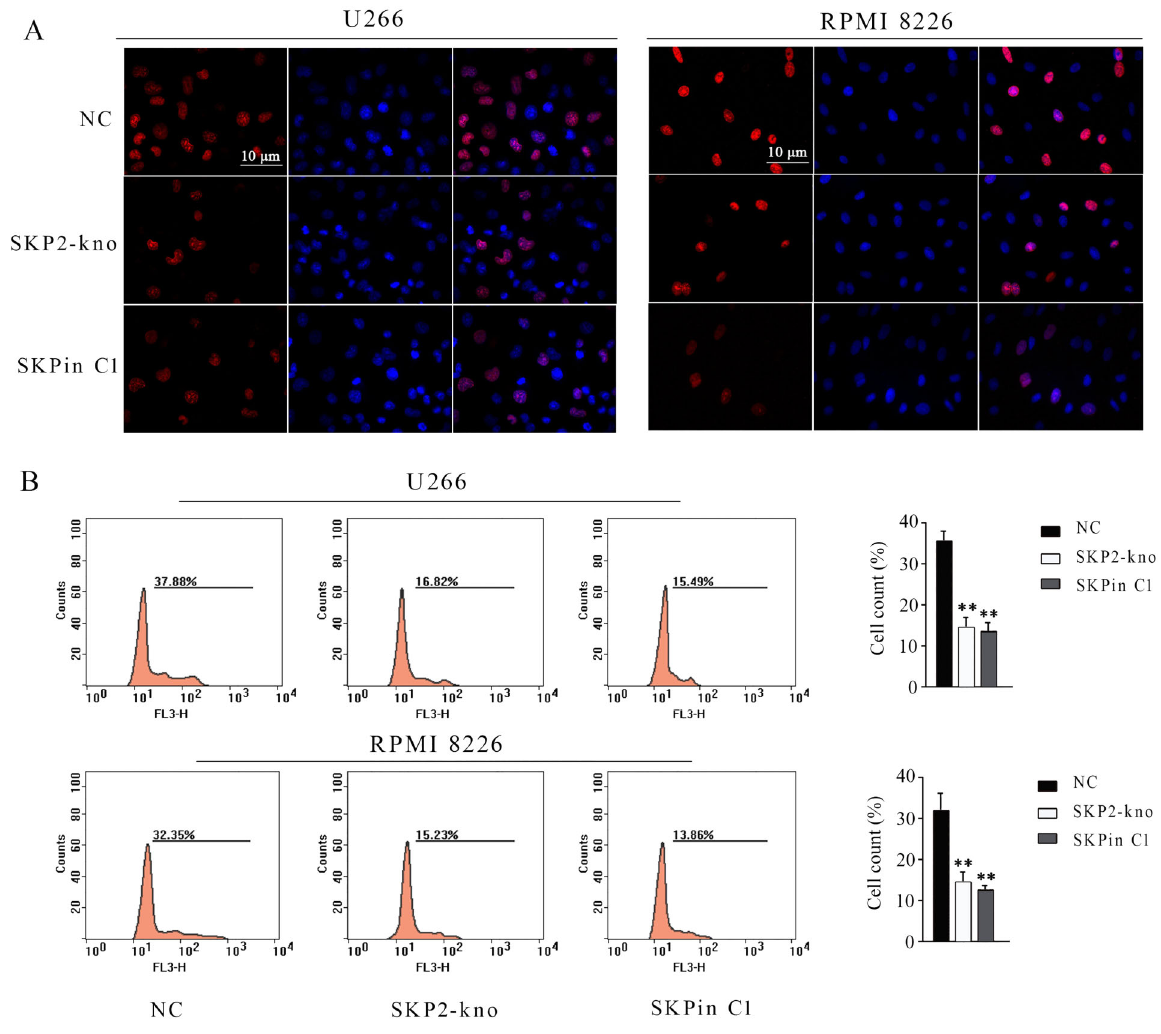
Figure 4. Effect of SKPin C1 treatment and SKP2 depletion on the proliferation of U266 and RPMI 8226 cells treated with 25 m M SKPin C1 or transfected with the siRNA that targeted SKP2, evaluated by Edu staining assay ( A ). Flow cytometry analysis of the number of cells with positive Edu staining ( B ). Data are reported as means ± SD. **P o 0.01 vs control group (NC) (ANOVA). SKP2-kno: SKP2